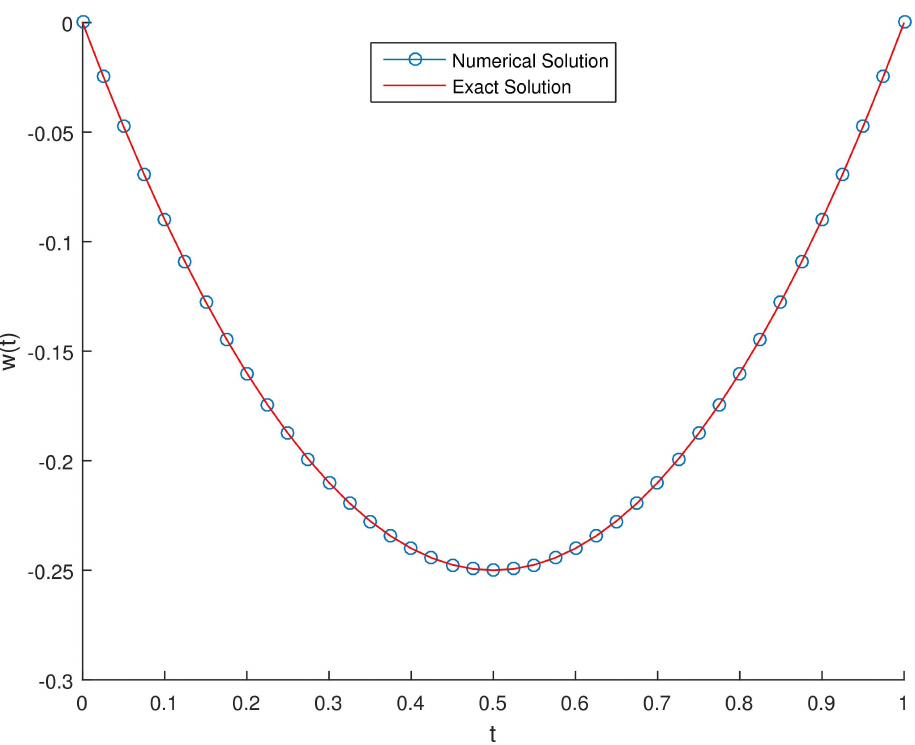
Figure 6. The behaviour of approximate and the exact solutions for Example 2 with τ = 0.001. In Figure 7, we graphically illustrate the absolute error acquired by the present scheme.